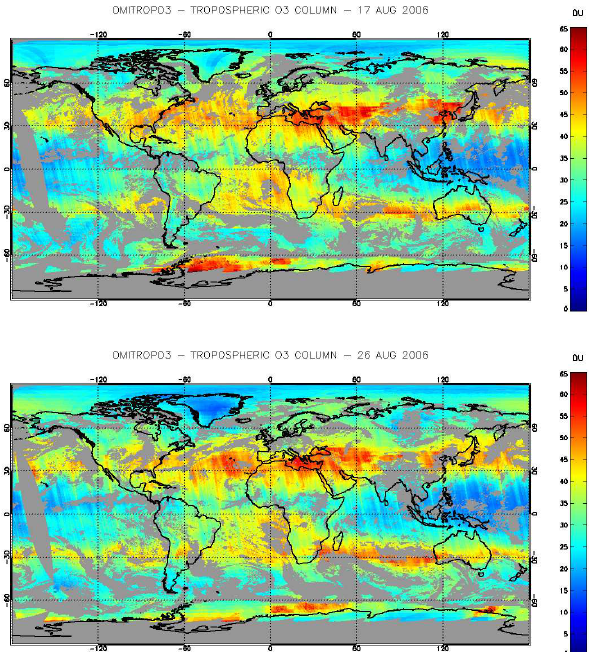
Fig. 12. Global tropospheric ozone fields simulated by the TM5 CTM on August 17 (top) and 26 August (bottom)